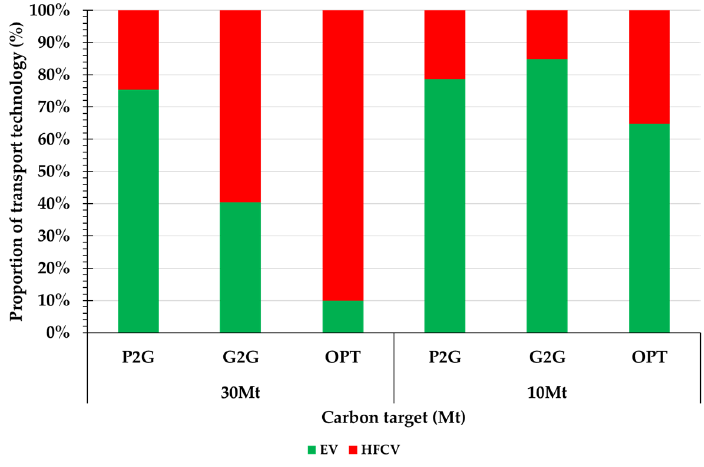
Figure 7. The proportion of each transport technology.